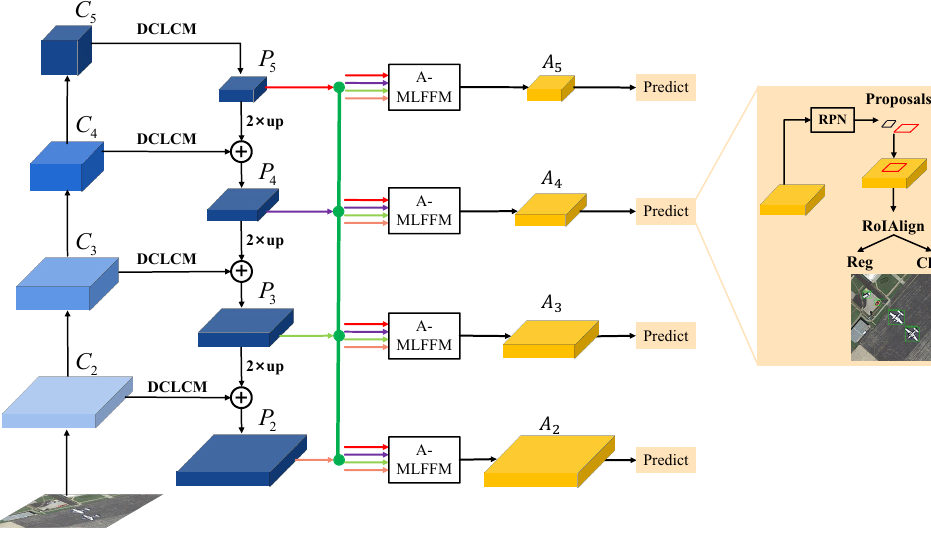
Figure 2. Flowchart of the proposed